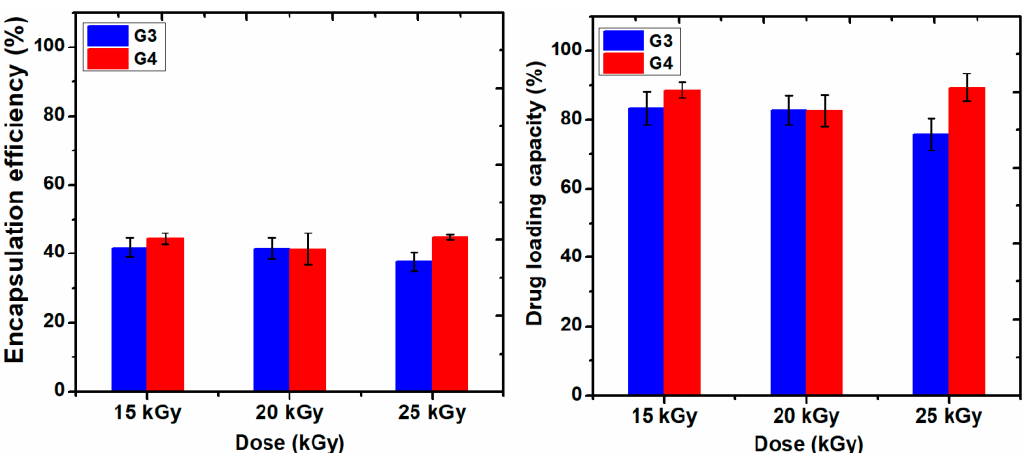
Figure 9. The encapsulation e ffi ciency (%) and drug loading capacity (%) of hydrogels.